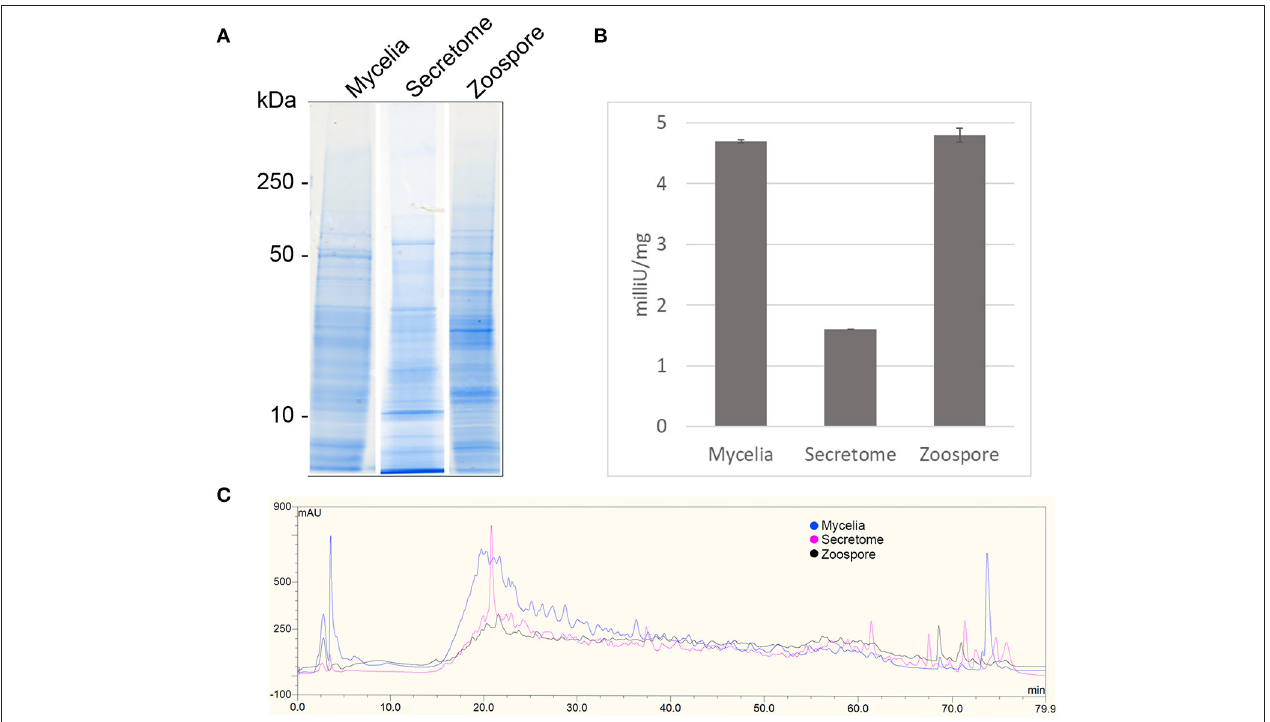
FIGURE 2 | Quality control of sub-proteomes. (A) SDS-PAGE analysis of P. cinnamomi sub-proteomes. (B) Glyceraldehyde phosphate dehydrogenase activity within each sub-proteome indicating relative levels of contamination of intracellular proteins in the extracellular proteome. (C) 214nm UV High pH reverse phase HPLC separation of 500 µ g of each sub-proteome demonstrating sufficient peptide separation and differing protein content.